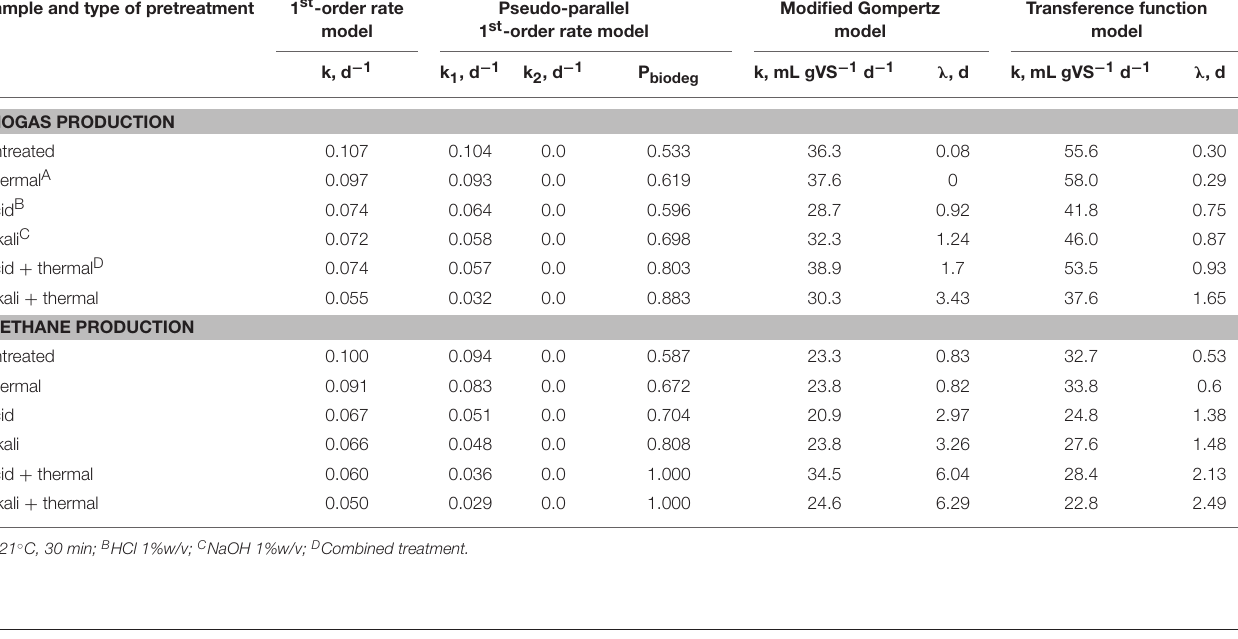
Frontiers in Energy Research |